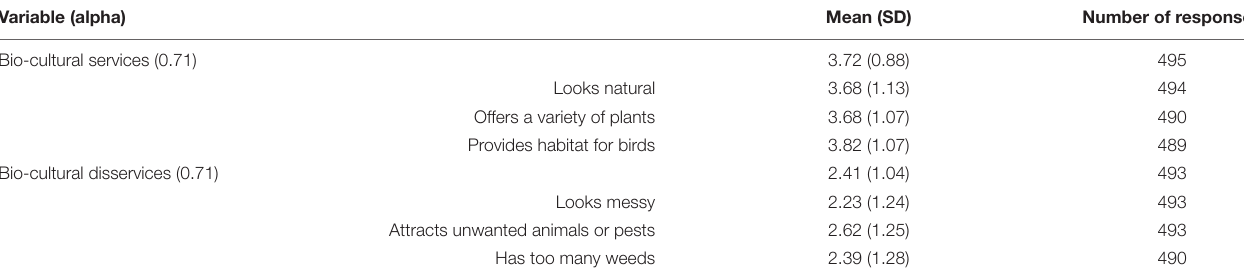
TABLE 1 | Dependent variables in composite scales (i.e., bio-cultural services and disservices) with their means and standard deviations. Variable (alpha) Mean (SD) Bio-cultural services